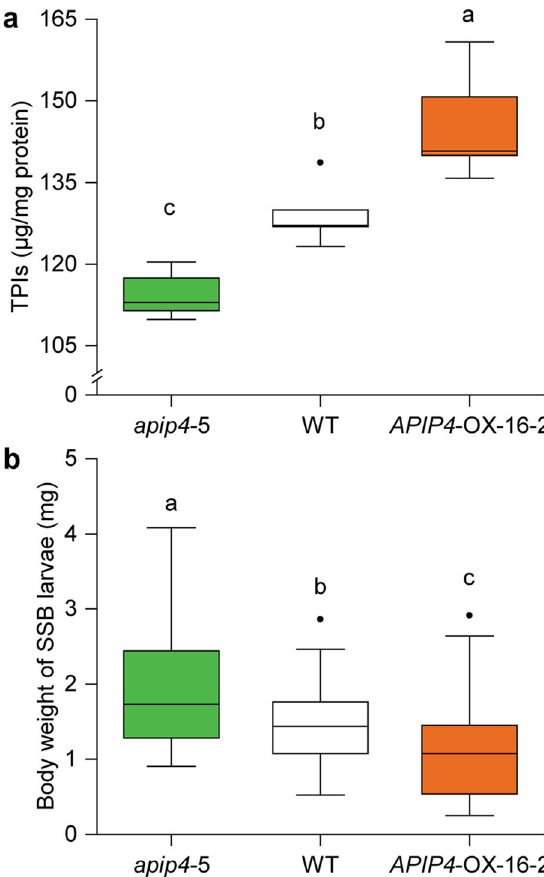
Fig. 5 Bowman-birk inhibitor AvrPiz-t interacting protein 4 ( APIP4 ) positively regulates TPIs production and SSB resistance. a The contents of trypsin protease inhibitors (TPIs) in apip4 -5, APIP4 -OX-16-2, and wild- type (WT) Nipponbare (NPB) rice plants ( n = 5). Exact P -values = 0.018 (WT vs apip4-5 ), 0.0093 (WT vs APIP4-OX -16-2), and 4.90e-05 ( apip4 -5 vs APIP4 -OX-16-2). b Weight of SSB larvae after fi ve days of feeding on apip4 lines ( n = 38) and APIP4 -OX lines ( n = 53) or WT rice plants ( n = 36). Exact P- values = 5.46e-03 (WT vs apip4-5 ), 4.72e-04 (WT vs APIP4-OX -16-2), and 5.21e-10 ( apip4 -5 vs APIP4 -OX-16-2). Boxplots indicate median (middle line), 25th, 75th percentiles (box), and maximum and minimum values (whiskers) as well as outliers (single points). Different letters indicate signi fi cant differences between treatments ( P < 0.05, one- way analysis of variance followed by Tukey ’ s honest signi fi cant difference test). ( Os02g0655200 ), bind to promoters of genes associated with the JA pathway (Supplementary Data 5). Moreover, the expres- sion patterns of these TFs and JA pathway genes were similar (Supplementary Data 5), strongly suggesting that these TFs control the expression of the identi fi ed JA pathway genes.